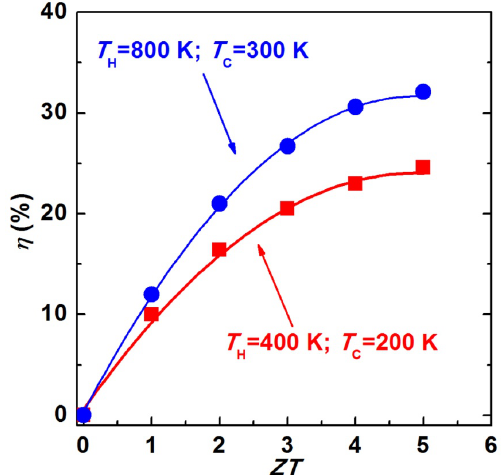
Figure 1. The maximum conversion efficiency dependence of figure of merit ( ZT ) values under certain working